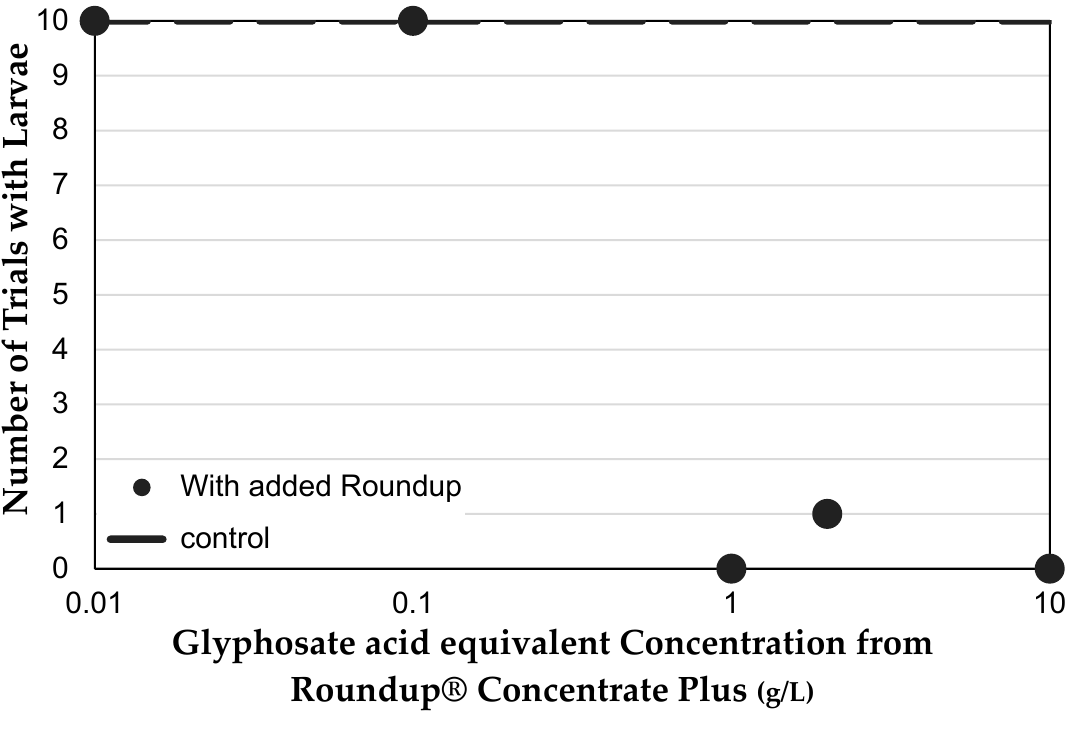
Figure 4. Effect of Roundup ® and glyphosate concentration on reproduction. Number of trials in which vials contained larvae after adult females had been present from day 7 to day 14 after eclosion. Lack of larvae most likely indicates high mortality of eggs (before or after they are laid) or early instar larvae.